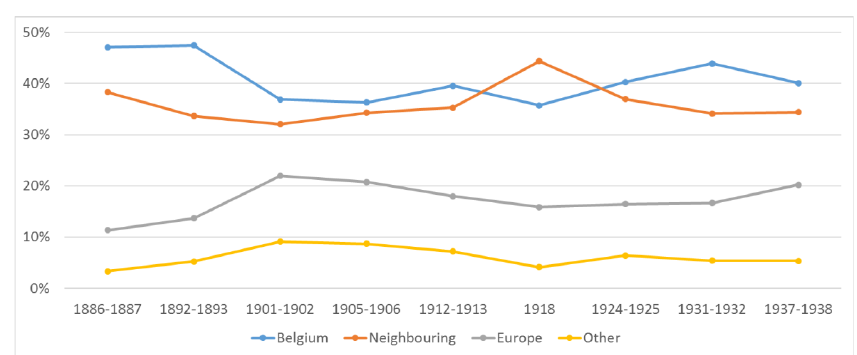
Figure 3: Vooruit - focus on Belgium versus other regions (1886-1938). Fig. 3 Vooruit — focus on Belgium versus other regions (1886–1938)